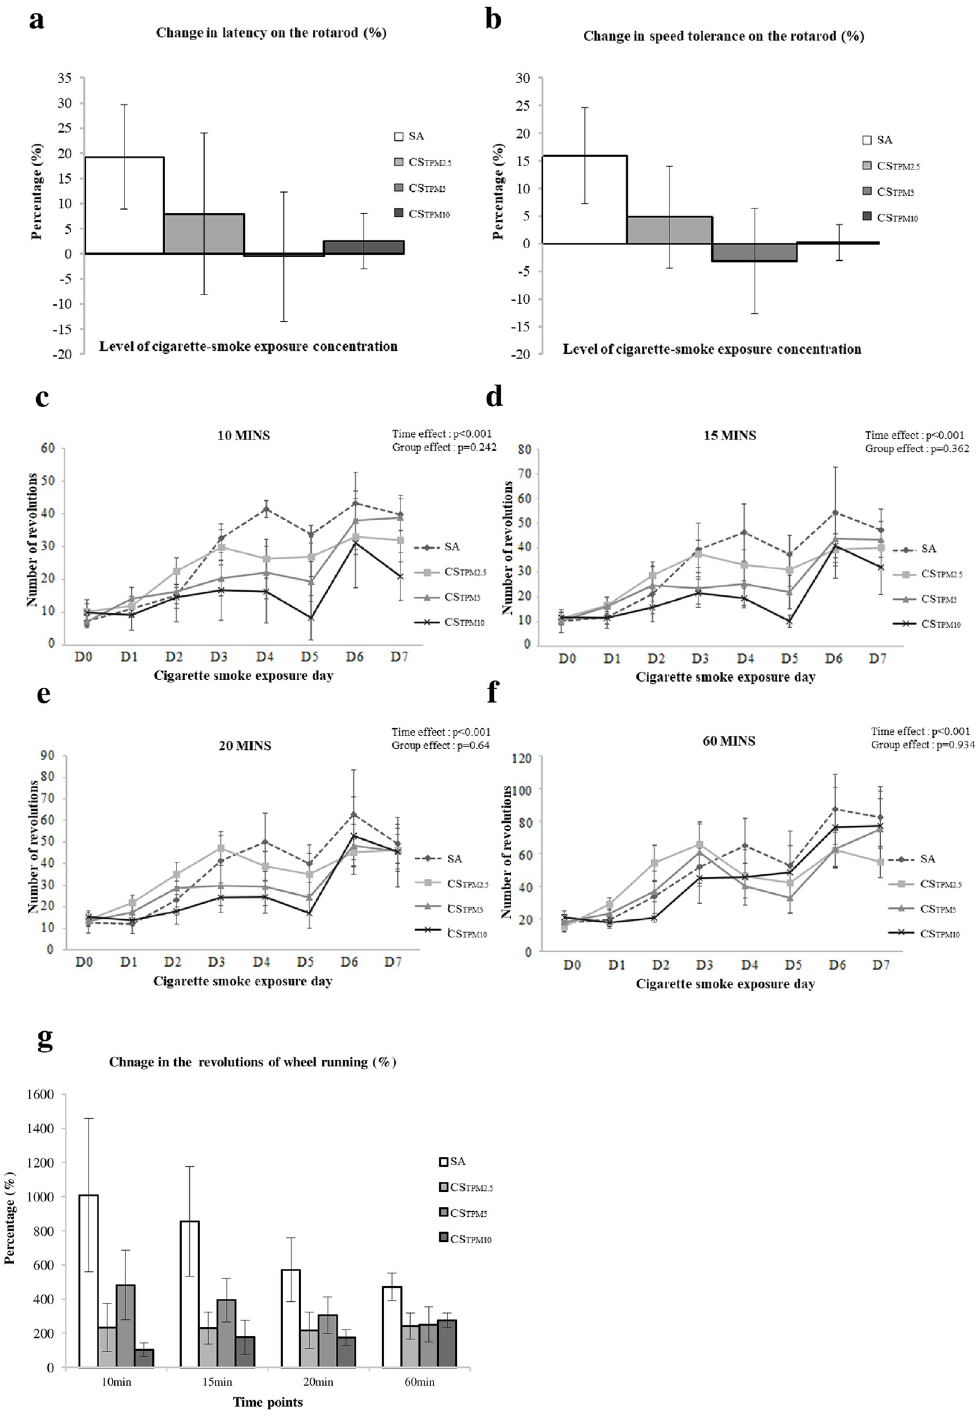
Fig 4. Changes in physical activities after acute cigarette smoking exposure. Data summarizing the percentage in ( a ) latency and ( b ) speed tolerance on the rotarod, and the graphs summarizing daily voluntary activities in terms of the revolutions in ( c ) the first 10 minutes, ( d ) the first 15 minutes, ( e ) the first 20 minutes, and ( f ) the entire 60 minutes recorded using voluntary wheel, between SA and other smoking exposure groups. ( g ) Histogram summarizing the percentage changes in revolutions of wheel running recorded at various time points. Data was presented as mean ± SEM. D indicates the day of experiment.